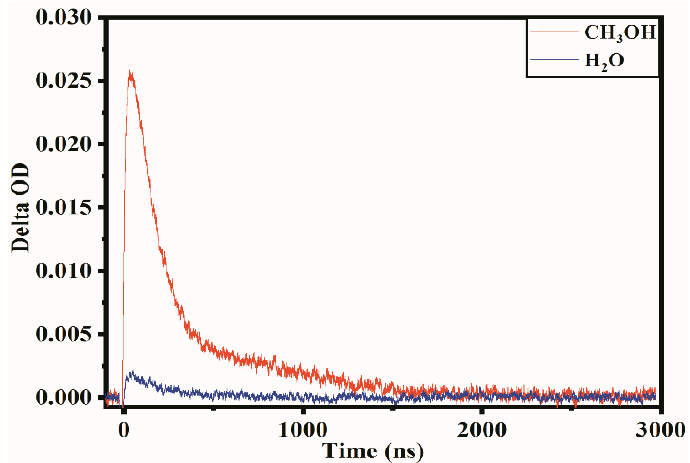
Figure 5. Temporal profiles of transient absorption spectrum in the present (red line) and absence of quencher (blue line).